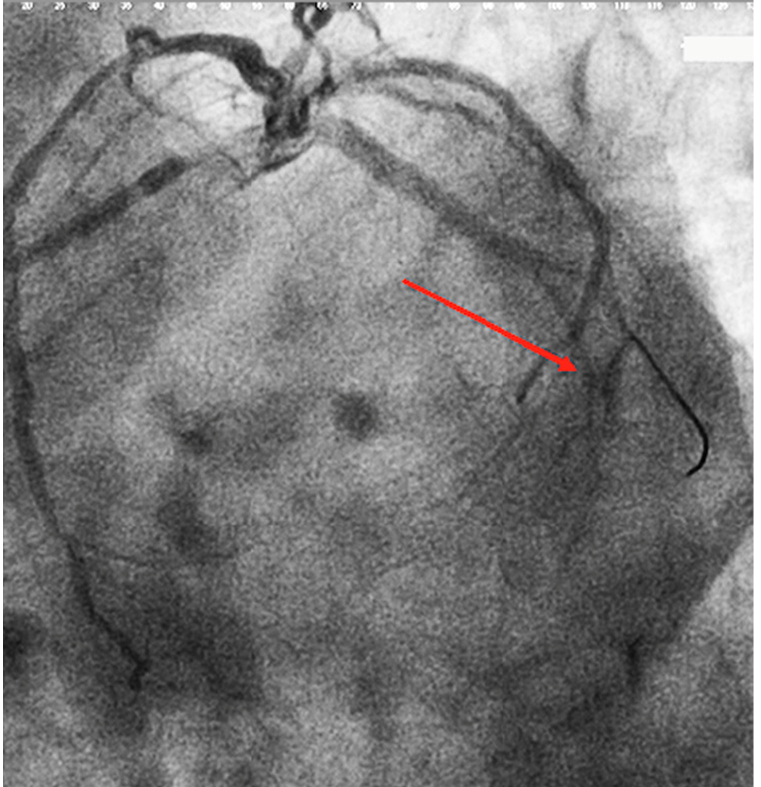
Figure 5. No-reflow phenomenon appear at the circumflex artery (indicated by the red arrow).